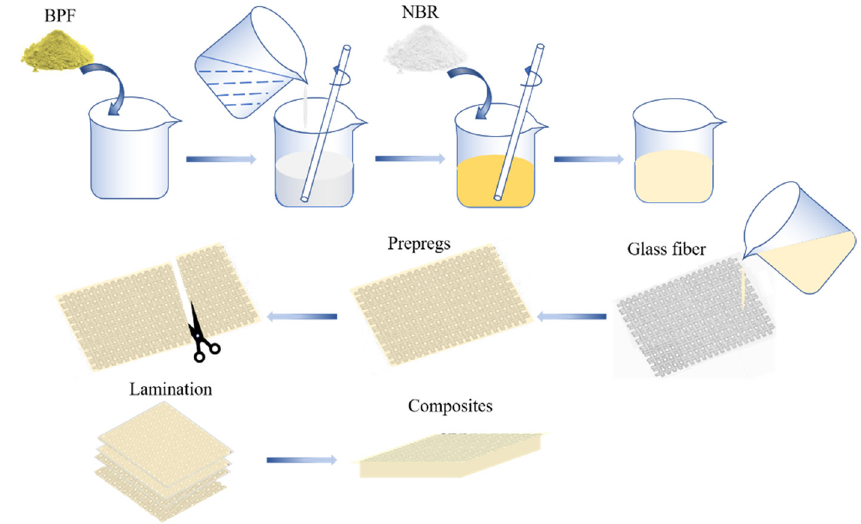
Figure 1: Process of composite preparation.